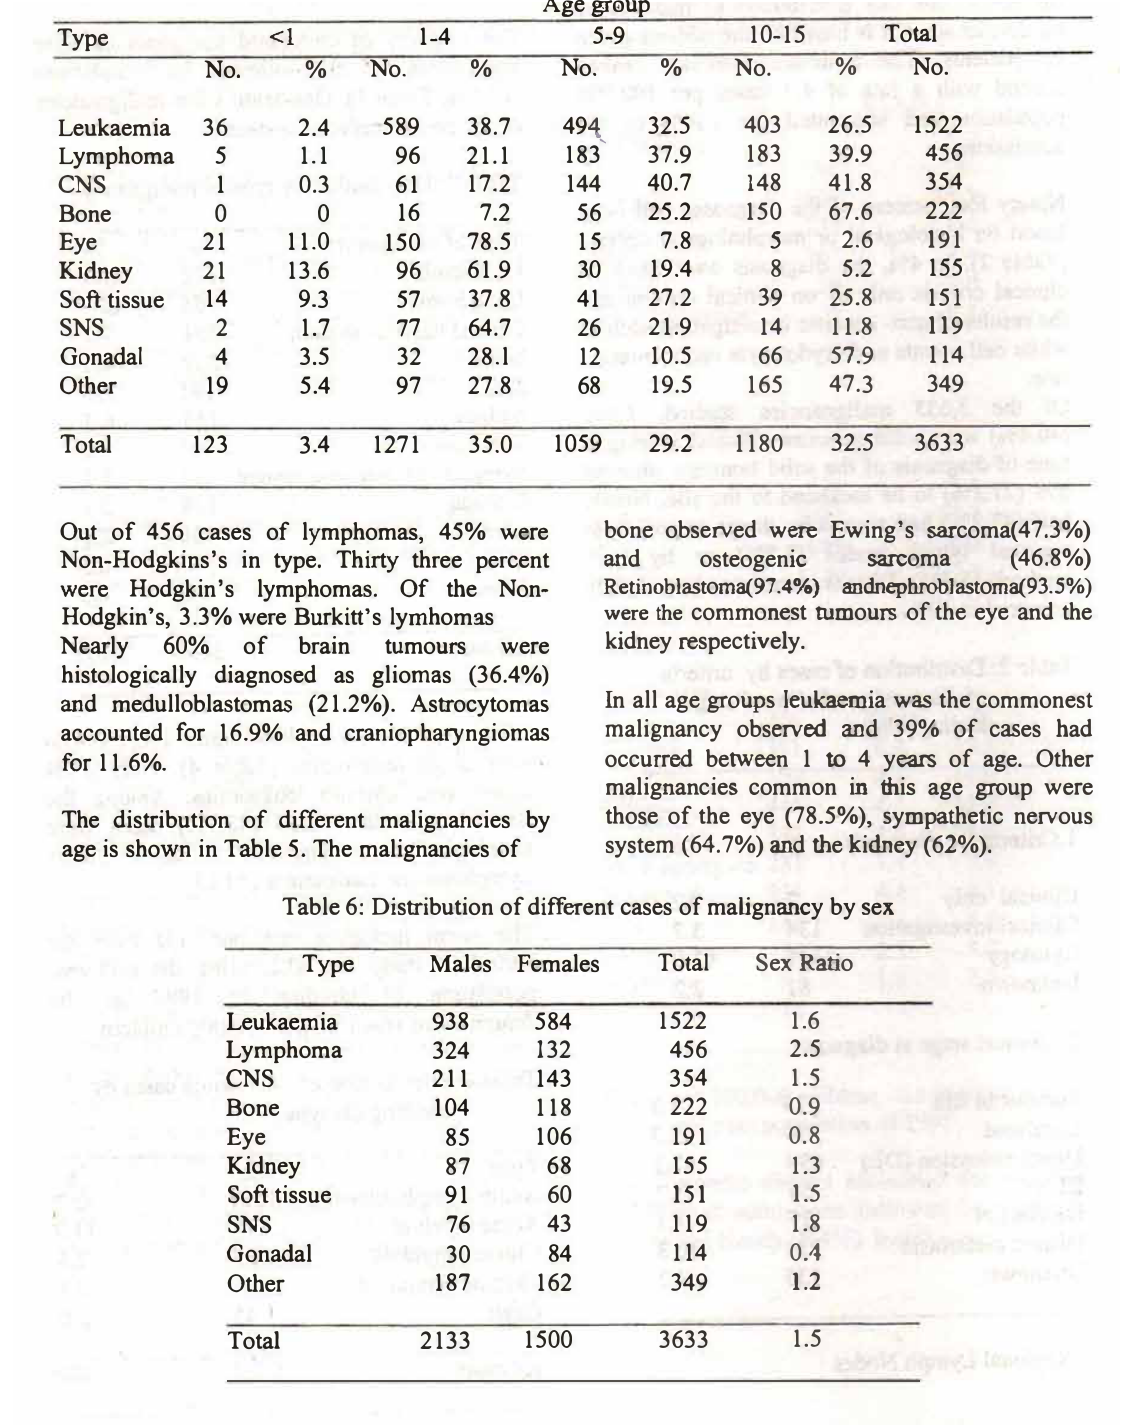
Table 5 :Distribution of different malignancies by age group Age group